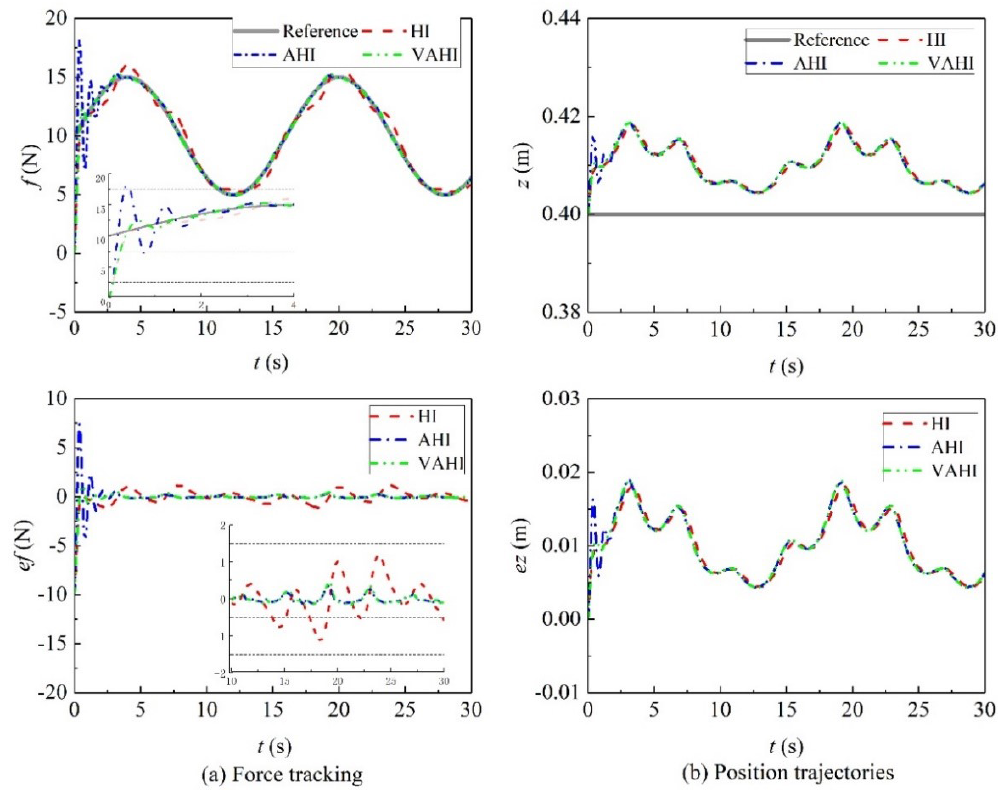
Figure 8. Tracking of the varying force with HI, AHI, and VAHI control schemes in the flat surface.